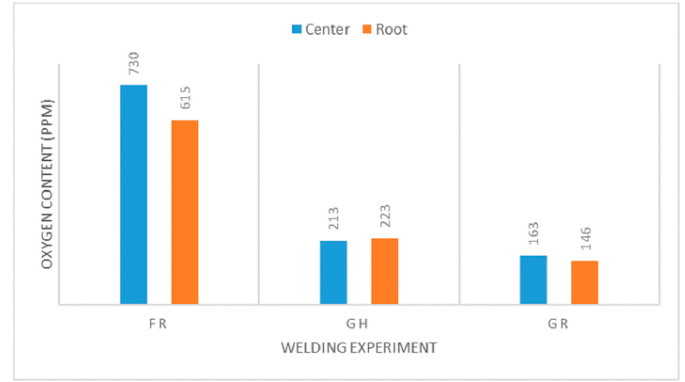
Figure 16. Oxygen content in the root and the center of the welds.